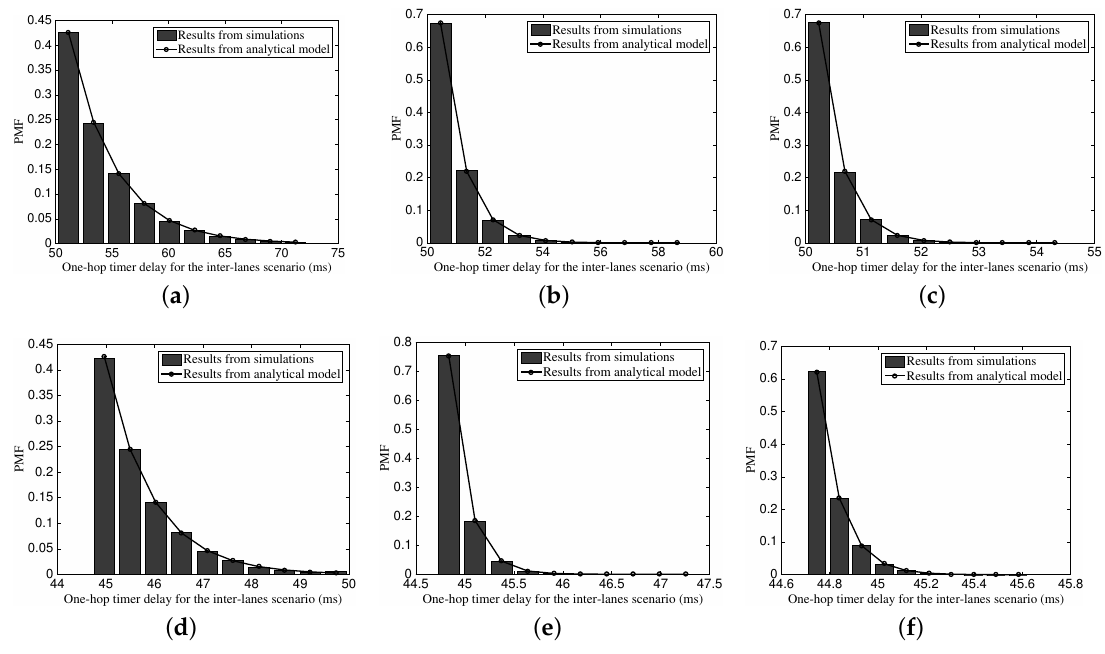
Figure 8. The PMF of one-hop timer delay for the inter-lane scenario with different vehicular traffic density: ( a ) ρ 2 = 10 vehs/km, v ∆ = 40 km/h; ( b ) ρ 2 = 50 vehs/km, v ∆ = 40 km/h; ( c ) ρ 2 =100 vehs/km, v ∆ = 40 km/h; ( d ) ρ 2 = 10 vehs/km, v ∆ = 20 km/h; ( e ) ρ 2 = 50 vehs/km, v ∆ = 20 km/h; ( f ) ρ 2 = 100 vehs/km, v ∆ = 20